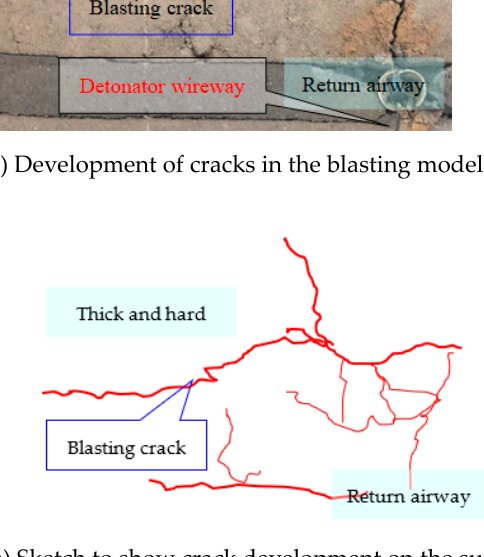
Figure 7. Crack development of test model after blasting: ( a ) development of cracks in the blasting model and ( b ) sketch to show crack development on the surface of the blasting model.